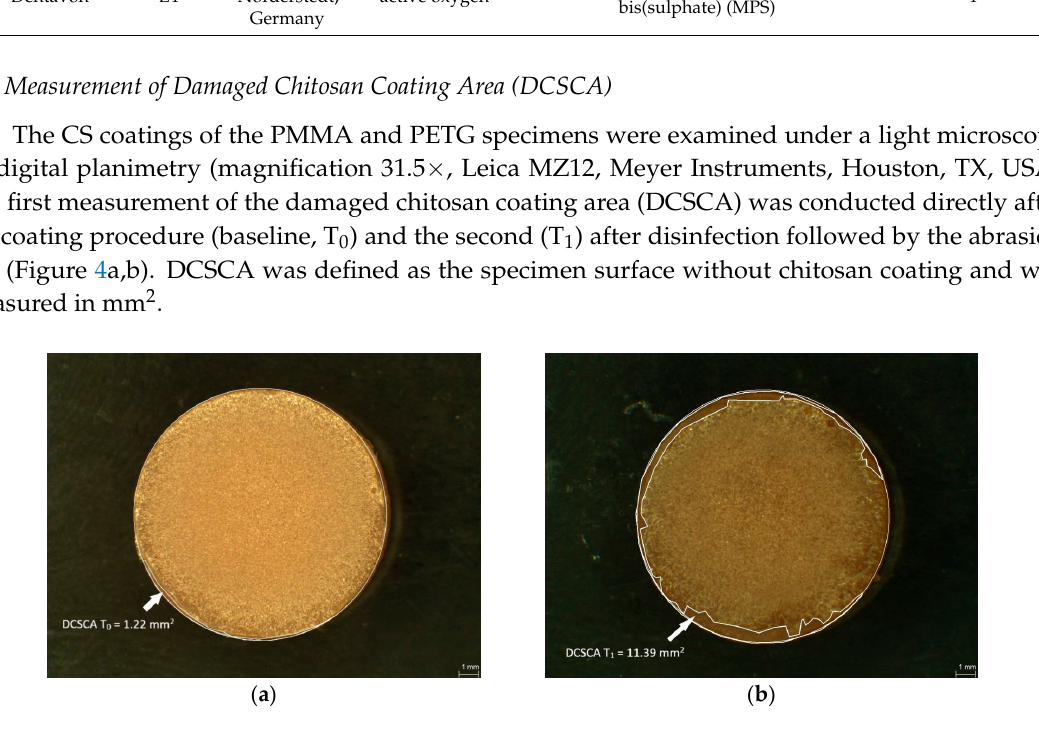
Figure 4. Selected specimens showing measurement of damaged chitosan coating area (DCSCA) at baseline T 0 , and T 1 (after disinfection/abrasion test): L2 PMMA specimen DCSCA at T 0 ( a ); L2